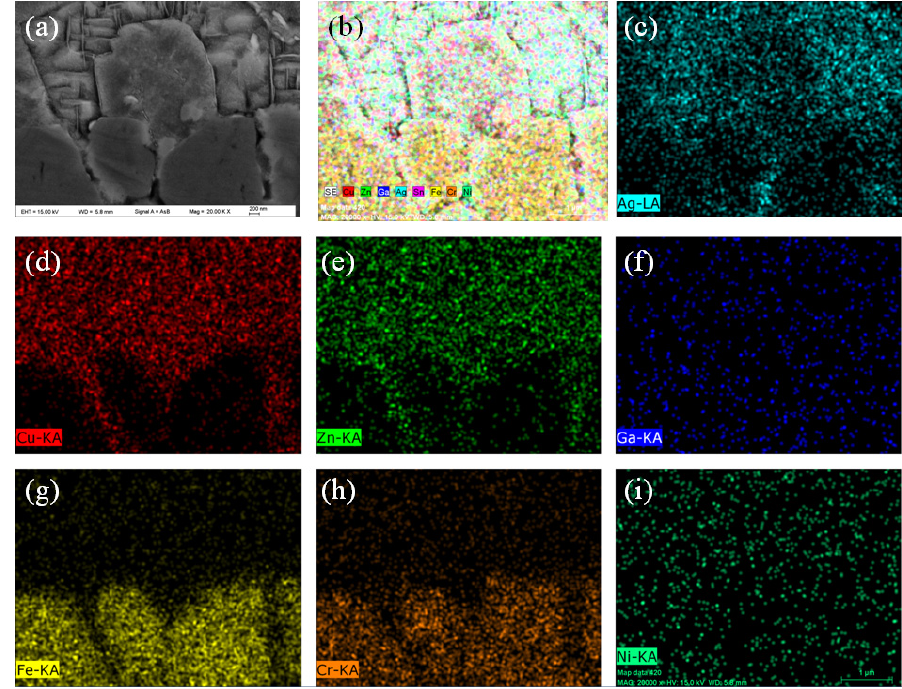
Figure 4. EDS results of the Ag16.5CuZnSn-2Ga brazed joints after 400 h: ( a ) Cross section morphology of brazed joints, ( b ) surface scanning, ( c ) Ag, ( d ) Cu, ( e ) Zn, ( f ) Ga, ( g ) Fe, ( h ) Cr, ( i ) Ni.